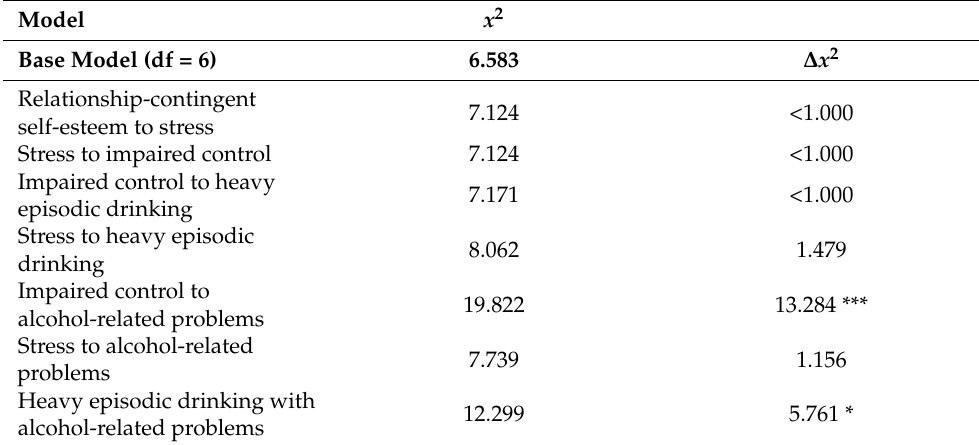
Table 3. Cisgender differences in the path